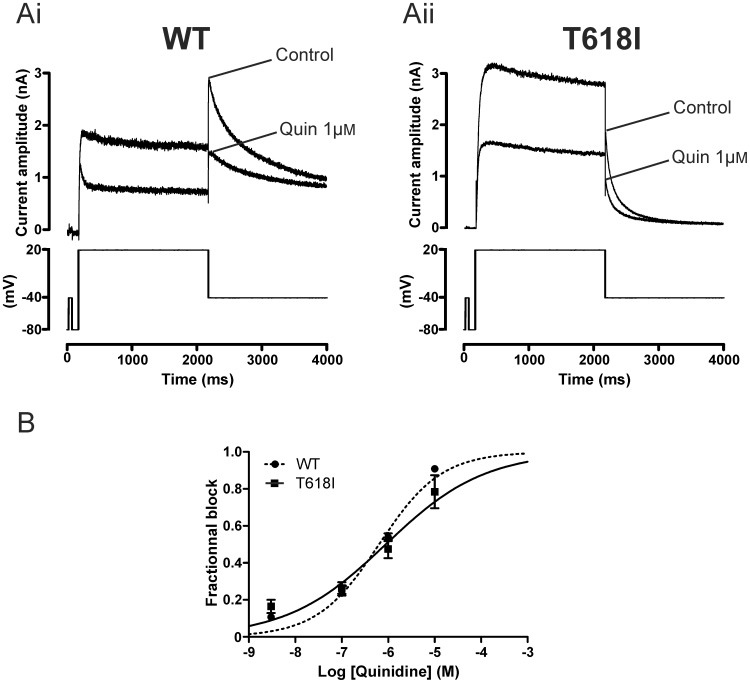
Effect of quinidine on WT and T618I IhERG under conventional voltage clamp.(A) Upper traces show IhERG elicited by voltage protocol shown in the lower panel (applied continuously once every 12 s) in control solution and after exposure to 1 µM quinidine (Quin). Ai shows data for WT IhERG, whilst Aii shows data for T618I IhERG. (B) Concentration response relations for inhibition of WT and T618I IhERG by quinidine. Fractional inhibition of IhERG was assessed for IhERG tails at each of 4 concentrations (n = at least 5 cells per drug concentration). Steady-state effects were achieved within ∼2 minutes of drug application and measurements were made at ∼3 minutes.